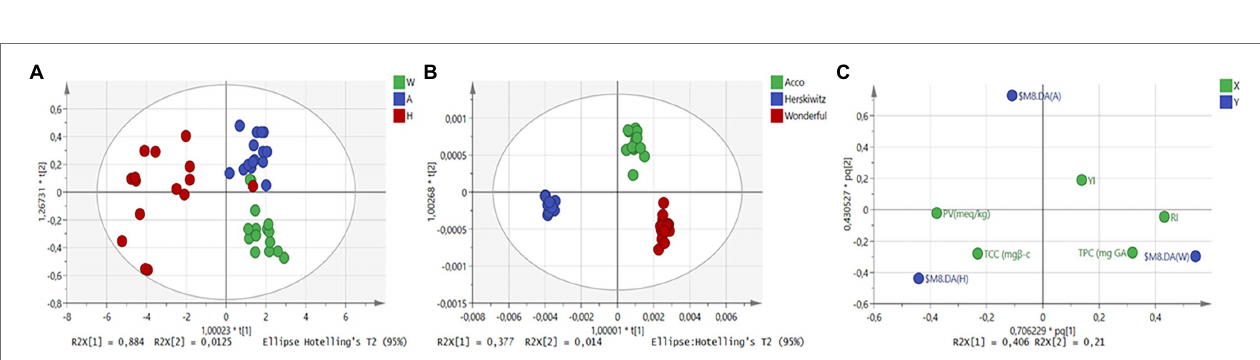
FIGURE 3 | OPLS-DA scores plots for NIR baseline-corrected spectra (A) , MIR baseline-corrected spectra (B) , and reference data plot (C) . The colour in (A) and (B) represents different cultivars (Acco, Wonderful, Herskawitz) of extracted pomegranate oil (sample number = 42).